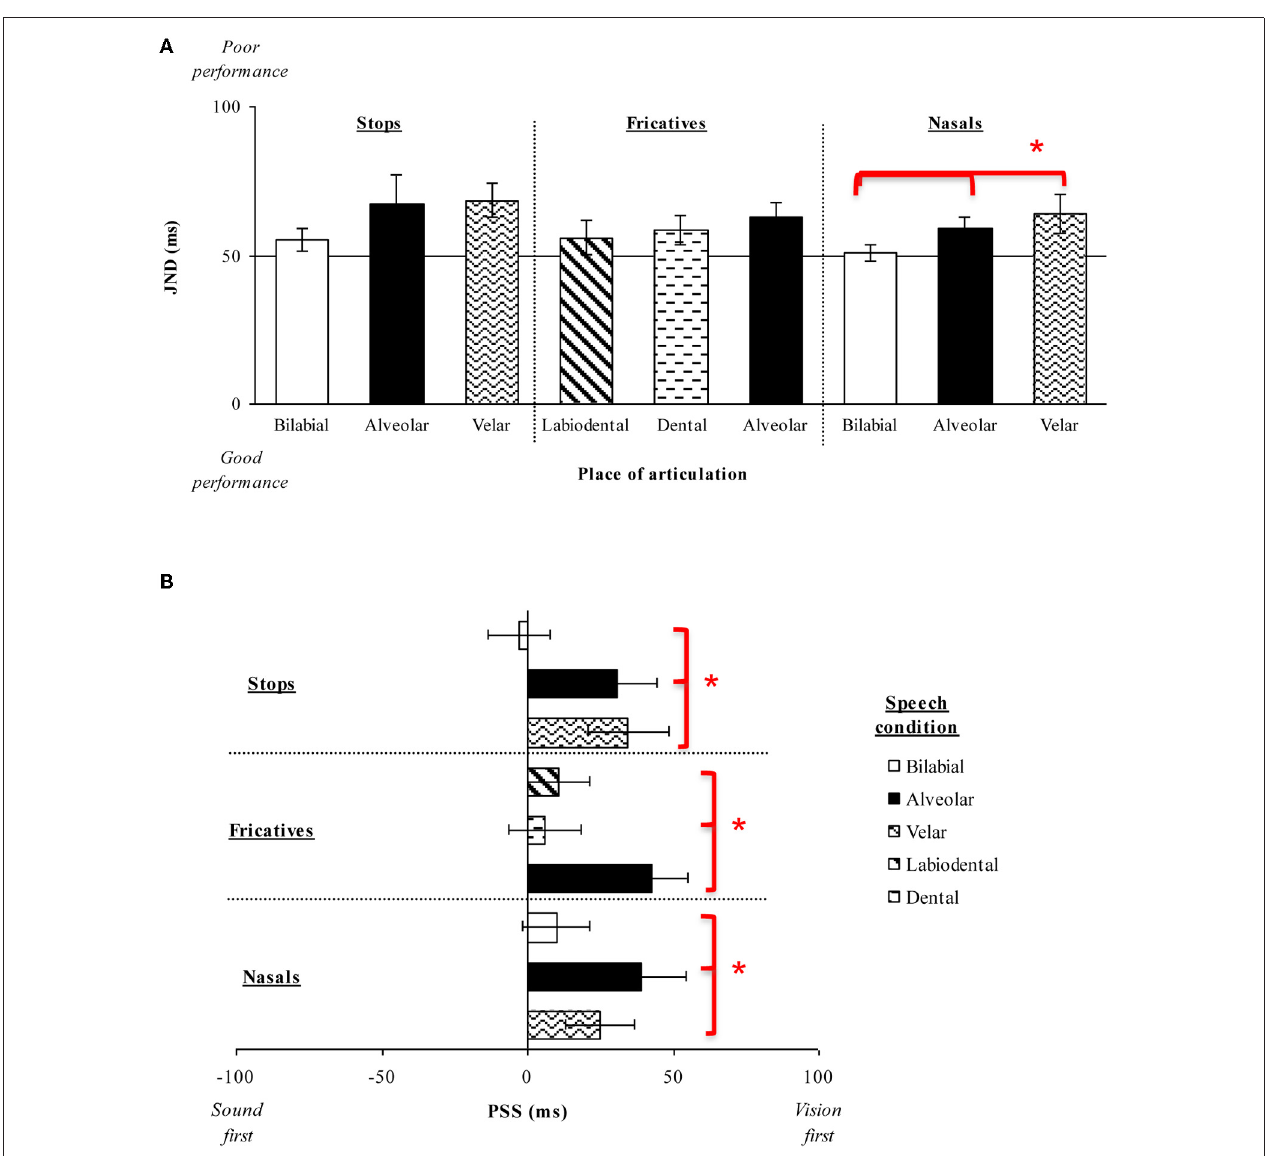
FIGURE 3 | (A) Average JNDs and (B) PSSs for the place of articulation of the consonant stimuli presented in Experiment 1. The error bars represent the standard errors of the mean. Asterisks indicate significant differences between the various stimuli